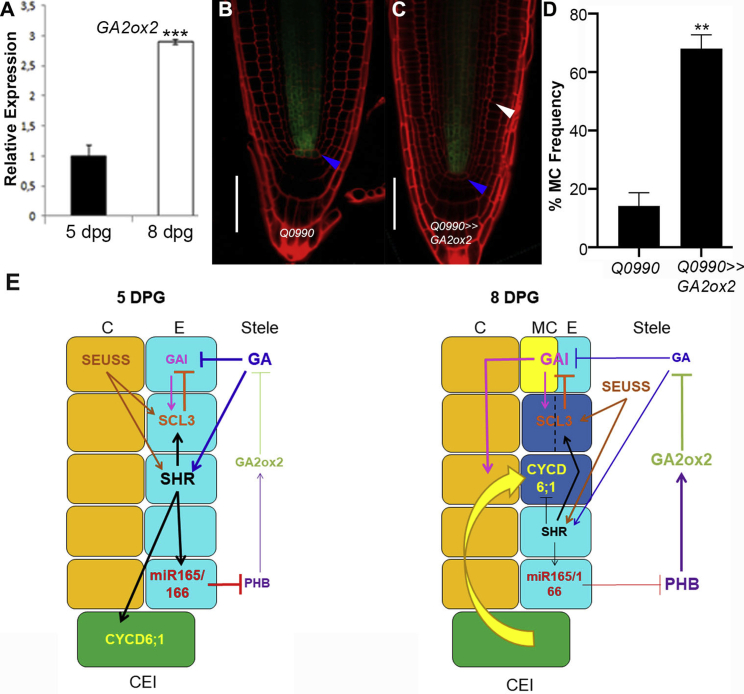
GA2ox2 Regulates MC Formation Cell Non-autonomously(A) Relative expression of GA2ox2 in 5 and 8 dpg old WT plants. N = 3.(B and C) Confocal images of meristems of Q0990 (B) and Q0990>>GA2ox2 plants at 5 dpg (C). Scale bars, 50 μm; white arrowhead indicates MC formative asymmetric division; blue arrowheads indicate the CEI.(D) Histogram depicting the percentage of MC formation in Q0990 and Q0990>>Ga2ox2 at 5 dpg. n = 20, N = 3.(A and D) n = 3; Student’s t test (∗∗p < 0.01; ∗∗∗p < 0.005). Error bars: SD.(E) Model: PHB levels increase between 5 and 8 dpg, resulting in increased GA2ox2 expression. Increased GA2ox2 levels promote the degradation of GAs in the vasculature, stabilizing GAI protein. GAI directs the accumulation of CYCD6;1 in the endodermis, promoting MC formation. Decrease levels of GAs after 5 dpg dampens SHR levels that regulate miR165 and 166 and SCL3 that in turn attenuate PHB expression and GAI activity, respectively. Orange, cortex (C); cyan, endodermis (E); yellow, middle cortex (MC); green, cortex/endodermis initial (CEI); blue, periclinally dividing cells (dashed line). Yellow arrow indicates the CYCD6;1 switch.See also Figure S4.